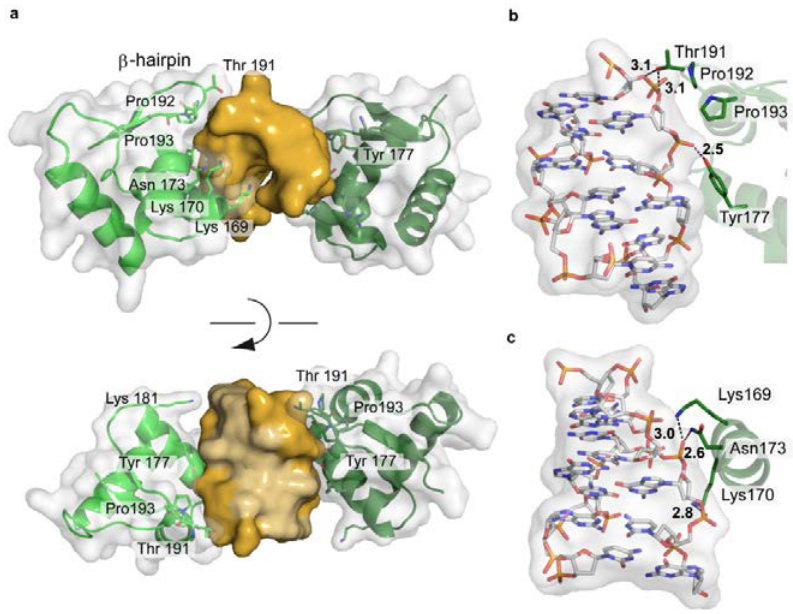
Figure 13. Structure of the Zα-domain of ADAR1 bound to left-handed Z-DNA (PDB code 3IRQ). ( a ) Schematic representation of the protein-DNA complex, highlighting the surface fit of the two macromolecules. The DNA is shown in gold, with the two bound proteins in green, overlaid with their semi-transparent surface; ( b , c ) Electrostatic interactions between ADAR1 and the Z-DNA